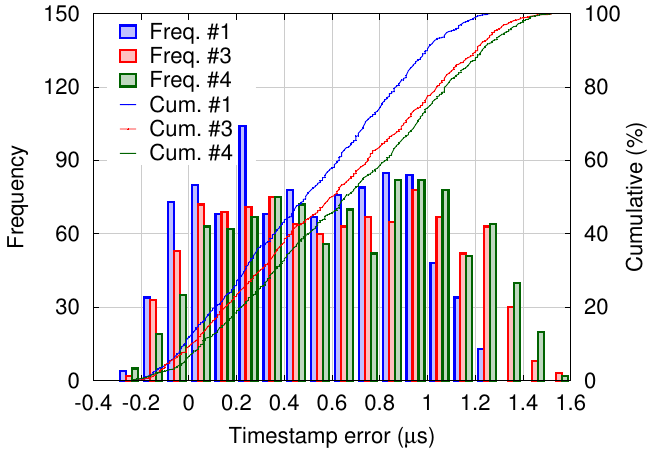
Figure 16. Histogram of the timestamp error between the master (#2) and each slave (#1, #3 and